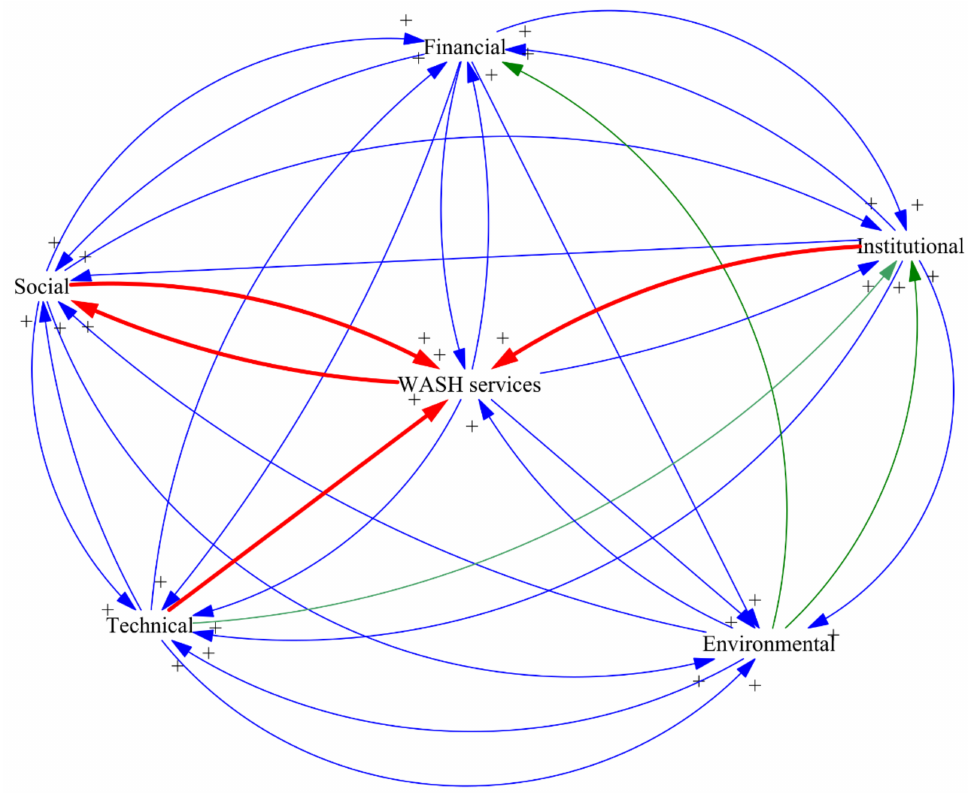
Figure 3. Causal Loop Diagram (CLD). The arrow shows the direction of the influence. The positive correlation is shown by (+) sign near the arrowhead. Red, blue, and green lines represent influence strength 3, 2, and 1,